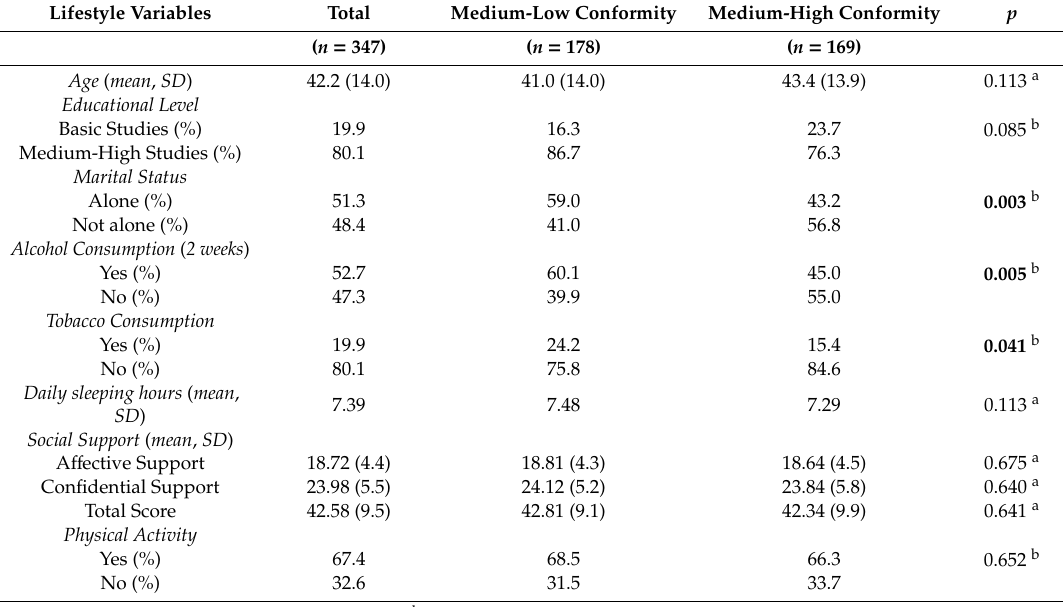
Table 1. Characteristics of the study sample by conformity to feminine roles.